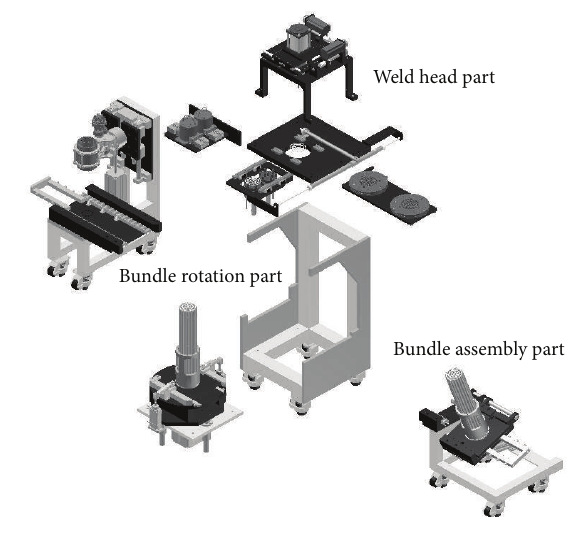
Figure 6: Auxiliary exploded and reassembled functions of top assembler.